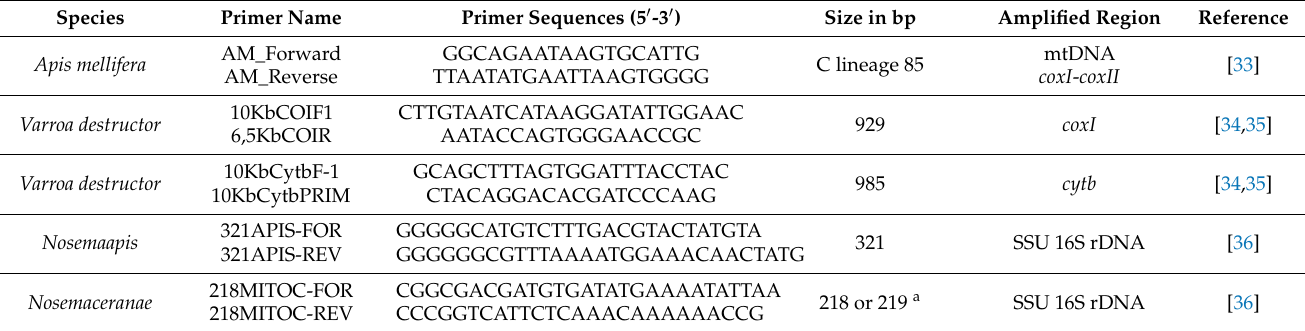
Table 1. Information on PCR primers used in this study to amplify eDNA from the honey